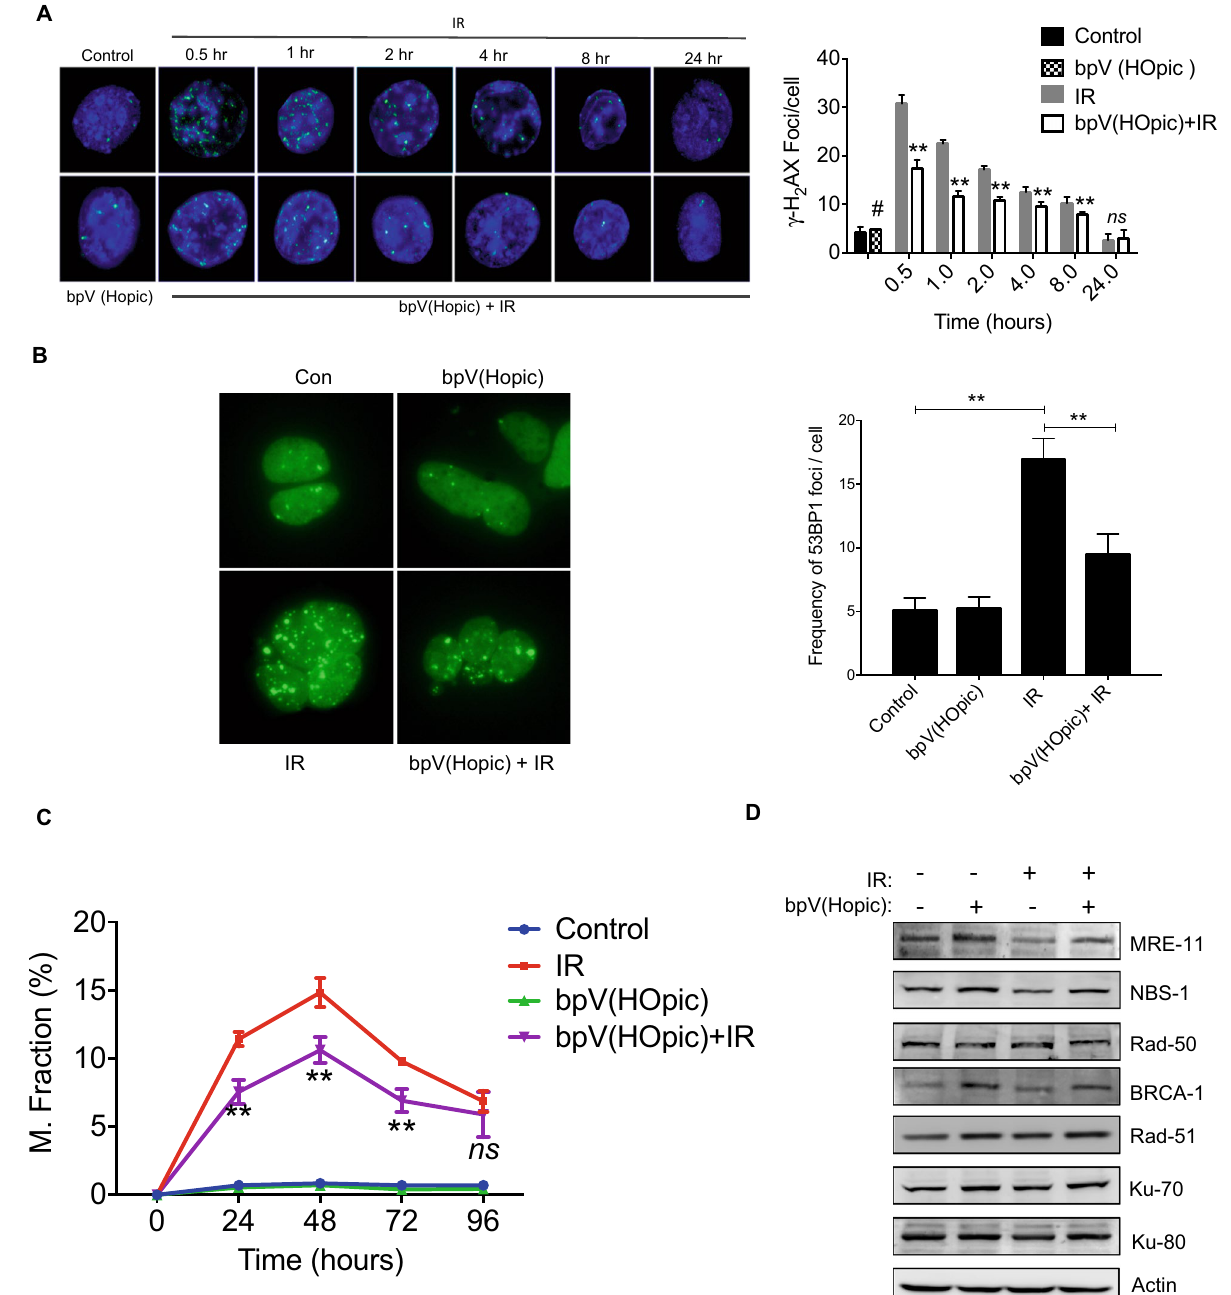
Figure 3. bpV(HOpic) reduces radiation induced DNA-DSBs and cytogenetic damage in NIH-3T3 cells. ( A ) Representative images of γ-H 2 AX foci formation in NIH-3T3 cells pretreated with 100 nmol/L bpV(HOpic) 1 h prior to 4 Gy IR exposure. The number of γ-H 2 AX foci per cell were scored and minimum 100 cells from each group replicate were scored. ( B ) Representative photomicrographs of 53BP-1 foci formation assay in HEK cells pretreated with 100 nmol/L bpV(HOpic) 1 h before IR exposure. Cells were stably transfected with GFP tagged 53BP-1 and were grown on coverslips. At 48 h post IR exposure, 53BP-1 foci were observed under a fluorescent microscope, and average foci per cell were scored. ( C ) IR induced cytogenetic damage (micronuclei fraction) in bpV(HOpic) (100 nmol/L) pretreated NIH-3T3 cells. ( D ) NIH-3T3 cells were pretreated with bpV(HOpic) 1 h before irradiation, and whole-cell lysates at 1-h post IR exposure were subjected to immunoblotting for indicated proteins. Error bars are mean ± SD (n = 4) from two independent experiments. # = IR vs unirradiated control ( p < 0.01); * p < 0.05; ** p <